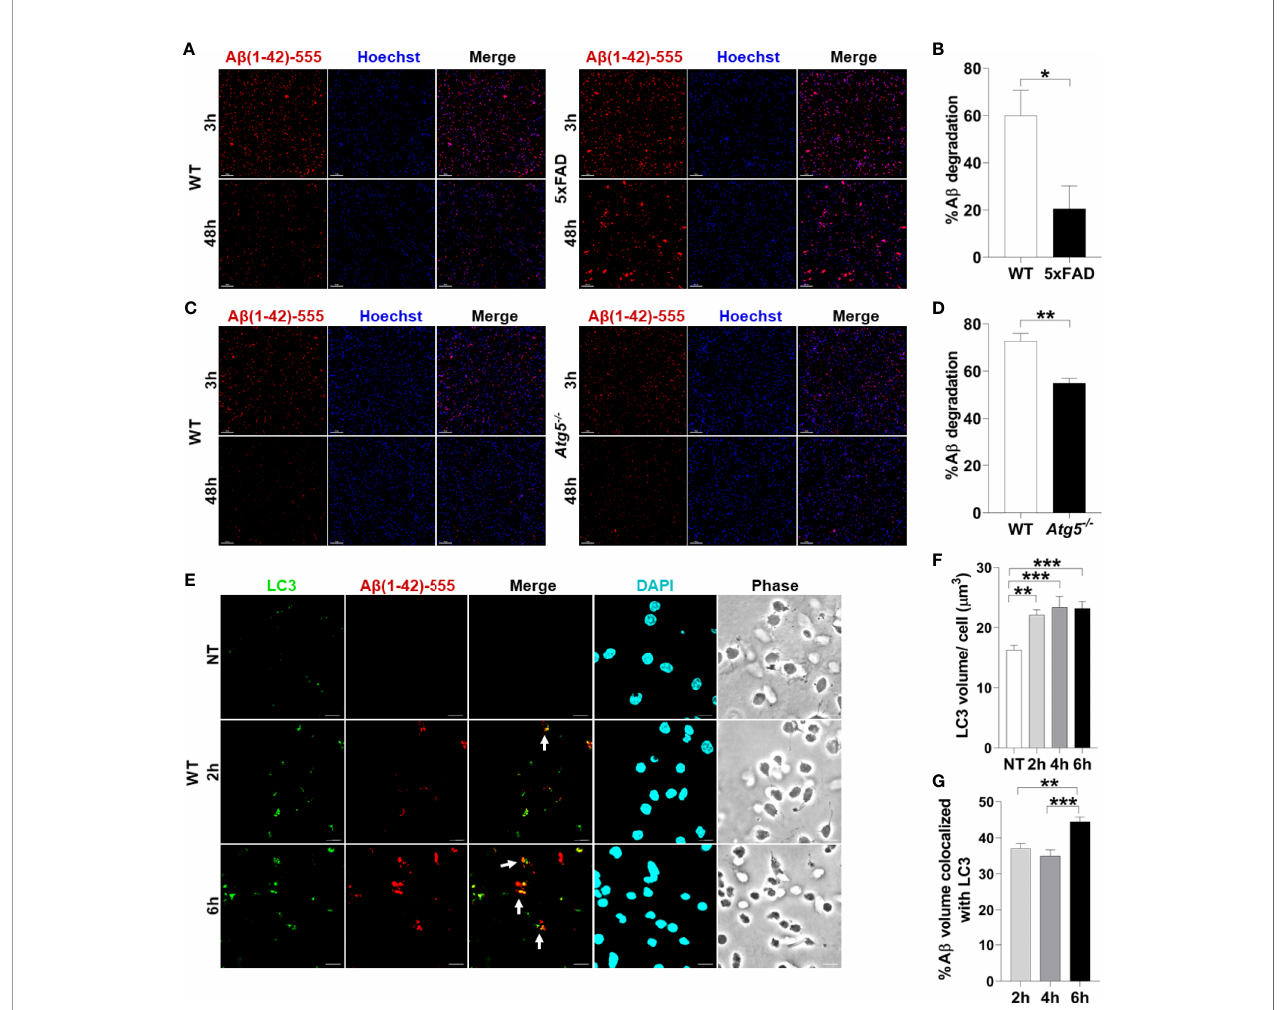
FIGURE 1 | A b degradation is diminished in 5xFAD microglia and autophagy knockout microglia. (A) Representative confocal images of fl uorescent-A b (red) in primary microglia isolated from 4-6-month-old 5xFAD and sex- and age-matched WT littermate ’ s brains treated with A b for 3 or 48h. Scale bar: 10µM. (B) Quanti fi cation of degradation of fl uorescent-A b (red) by degradation assay of the images represented in (A) (n = 3). Values are % of A b volume reduction ± SEM calculated by scoring 5 randomly chosen 20x fi elds of view per biologic replicate. Statistical analysis was performed using unpaired two tailed Student ’ s t- test. (C) Representative confocal images of fl uorescent-A b (red) added to primary microglia isolated from 2-3-month-old WT and Atg5 -/- mice ’ brains for 3 and 48h. Scale bar: 10µM. (D) Quanti fi cation of images represented in (C) were completed as described in (B) (n=3). Statistical analysis was performed using unpaired two tailed Student ’ s t-test. (E) Representative confocal images of LC3 (green) in fl uorescent-A b (red) treated primary WT microglia for 2,6h. Colocalization is represented in yellow as indicated by arrows. (F) Quanti fi cation of LC3 volume from cells treated as in (E) for 2,4,6h performed using Imaris software (n = 4) (12 images per biologic replicate). Statistical analysis performed by matched one-way ANOVA. (G) Quanti fi cation of LC3 A b colocalization from cells treated as in (E) for 2,4,6h performed using Imaris software (n = 4) (12 images per biologic replicate). Statistical analysis performed by matched one-way ANOVA. *p ≤ 0.05, **p ≤ 0.01, ***p ≤